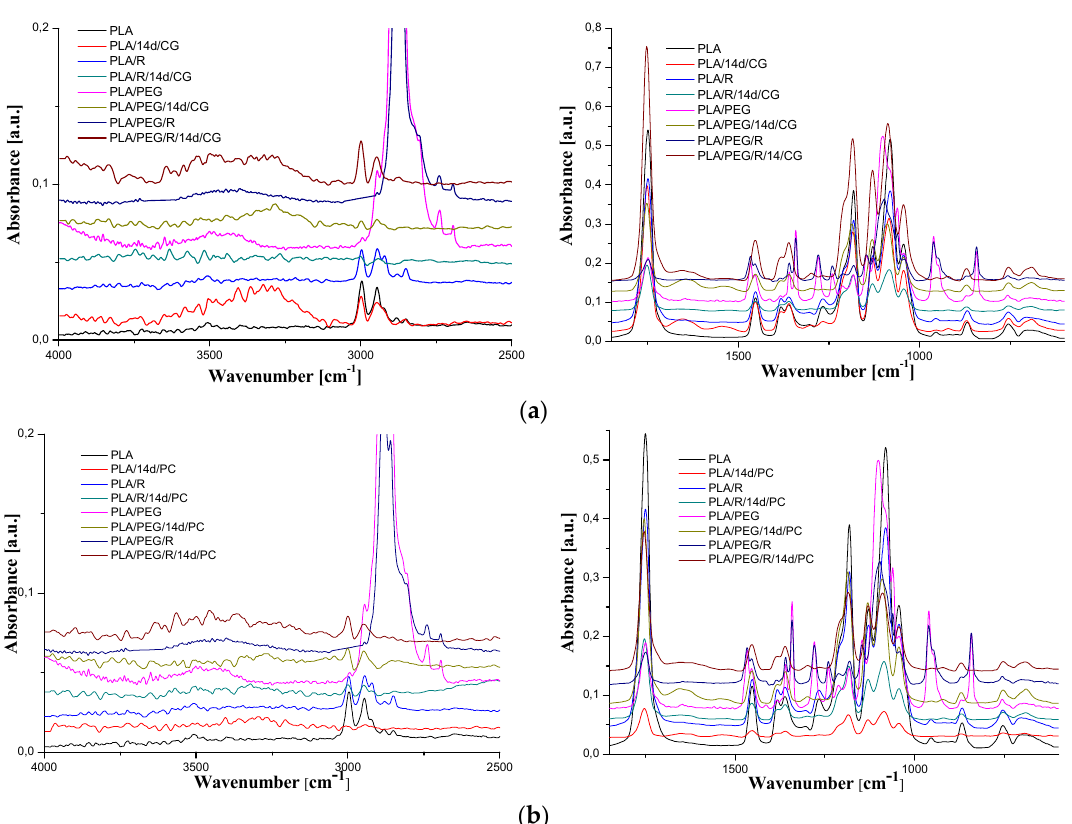
Figure 8. FTIR spectra of PLA-based samples before and after 14 days fungal exposure to: ( a ) Chaetomium globosum and ( b ) Phanerochaete chrysosporium .